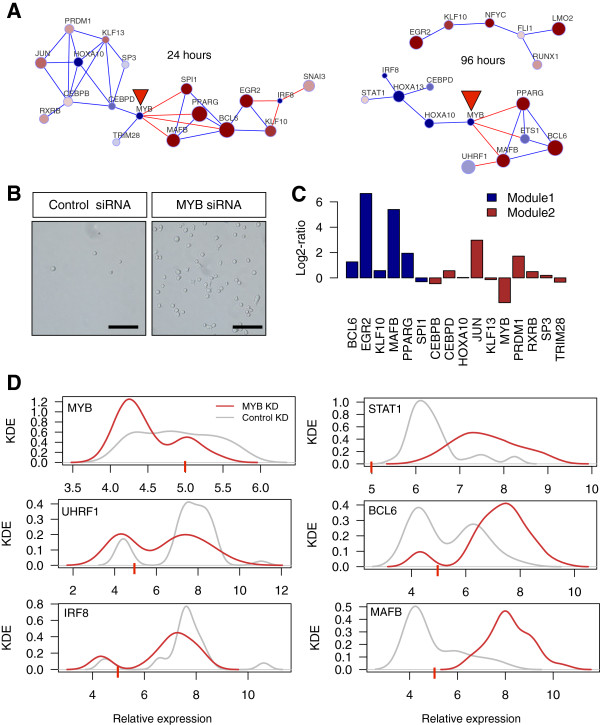
The integration of co-expression networks reveals MYB as a pivotal driver of monocyte differentiation. (A) Pairing of positive and negative co-expression networks at time points 24 h and also at 96 h reveals MYB as a pivotal driver (red arrow), hingeing two antagonistic network modules. (B) siRNA mediated knockdown of MYB in THP-1 cells leads to cellular differentiation observed by cell adherence to the dish after several washing steps. (C) Depletion of MYB in THP-1 cells induces expression of key pro-differentiation factors such as EGR2, MAFB, and PPARG as compared to siRNA control. (D) MYB knockdown followed by single-cell gene expression analysis reveals various modes of gene expression regulation and distribution (grey line = control (n = 43), brown line = MYB siRNA knockdown (n = 43), red bar = detection threshold at 5). Scale bar = 50 μm.